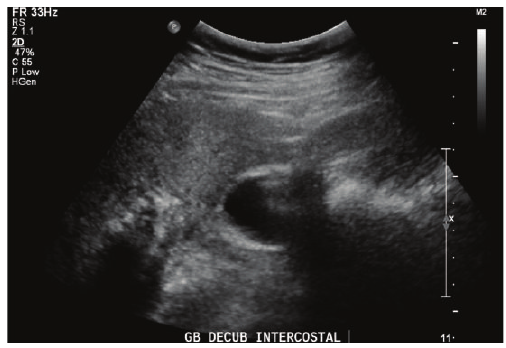
Figure 1: Abnormal gallbladder with thickened wall and mass in the fundus on ultrasound.